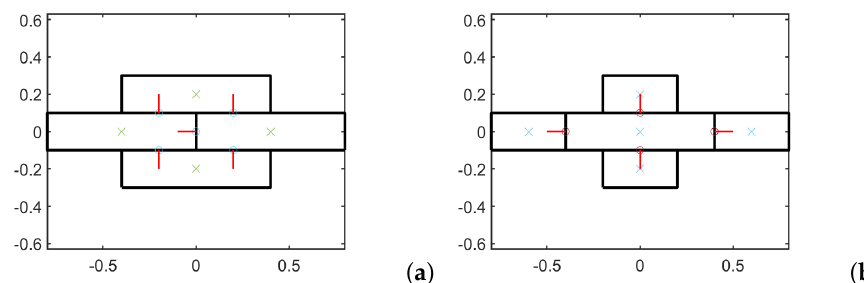
Figure 2. RVEs for the two microstures at scale s = 1: ( a ) texture 1 ( b ) texture